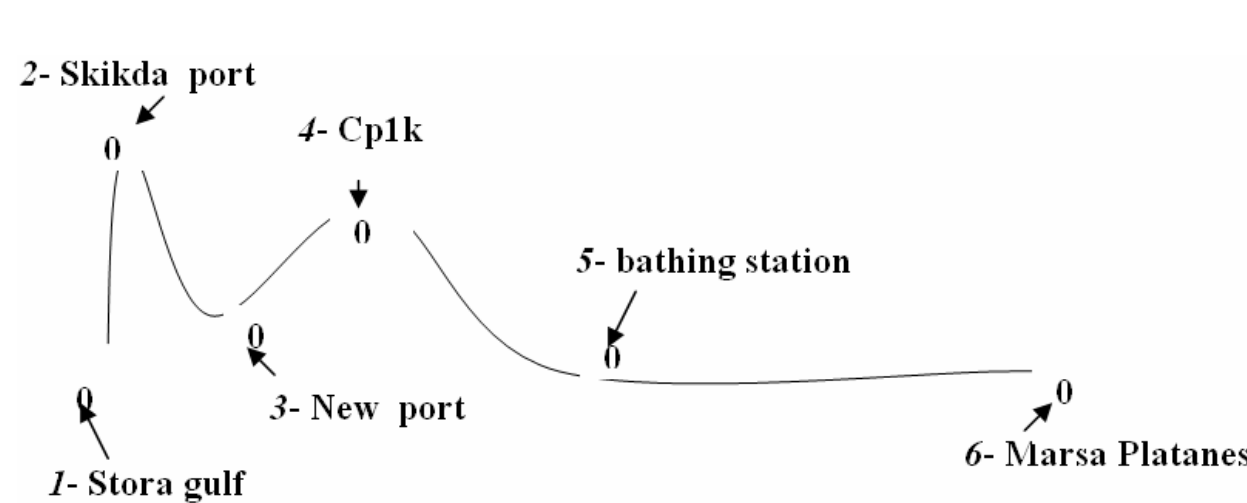
Figure 2 : Studied Littoral zone of Skikda bay(Algeria): 1-Fishing port located at the Stora gulf, 2-Ancient port located in the center of the town, 3-New port located at the entry of the industrial zone, 4-Effluents dumping from the Cp1k (Petrochemical complex of Skikda), 5-Bathing station post 7 Larbi Ben Mhidi, 6-The Platanes